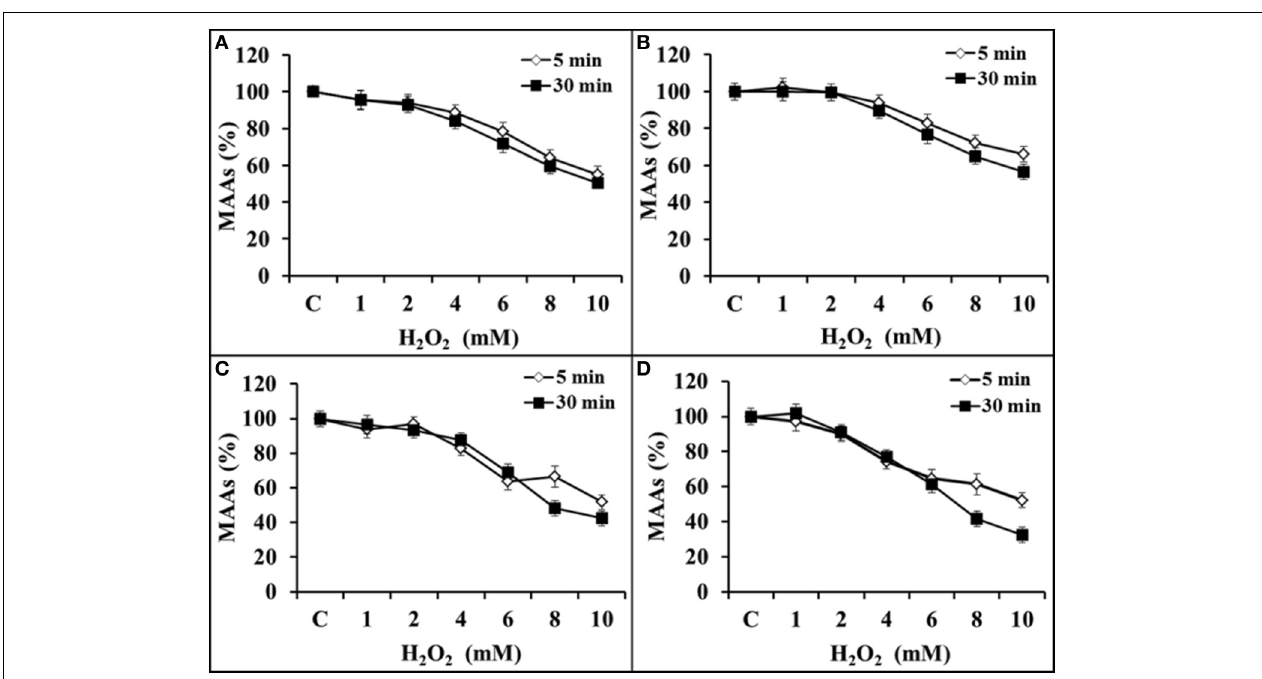
FIGURE 6 | Percentage inhibition of MAAs (0.075mmol.g dry wt − 1 ) against H 2 O 2 (0–10mM) at 323nm (A), 328nm (B), 335nm (C), and 340nm (D) after 5 and 30min of incubation in H 2 O 2 .